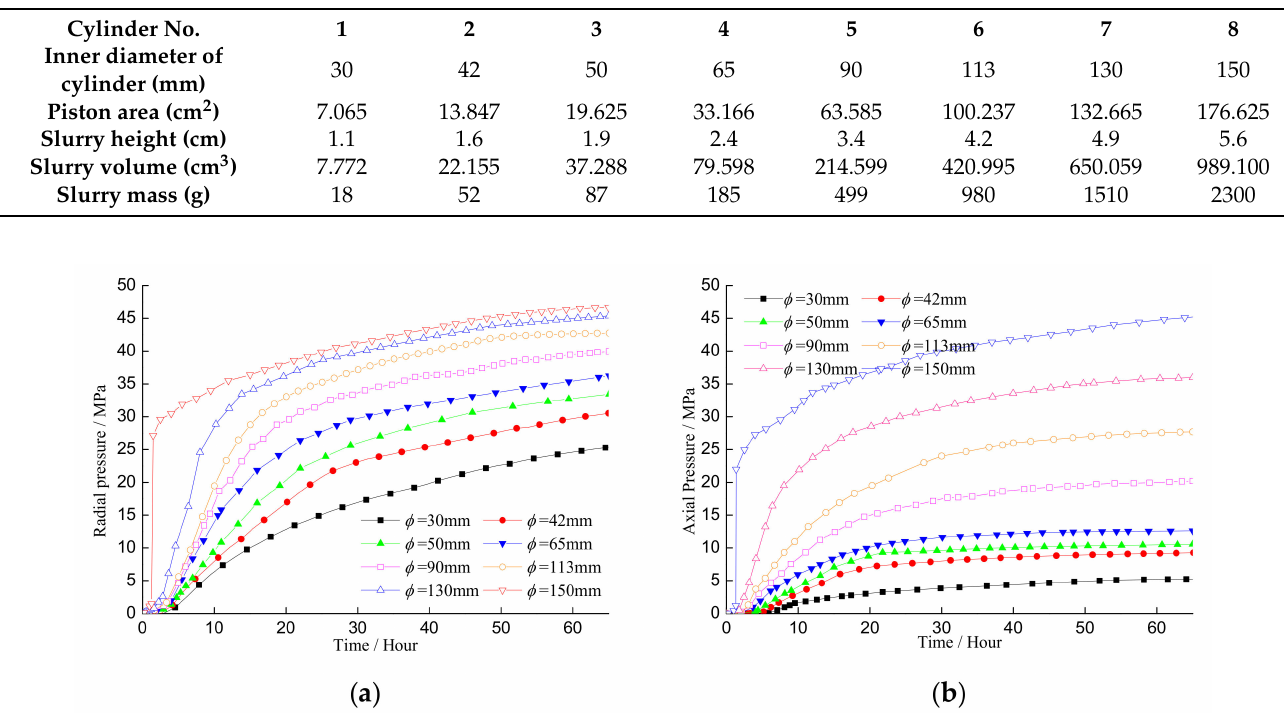
Figure 1. The test principle for the axial-output method. Table 1. Geometric parameters for cylinder and SCA.